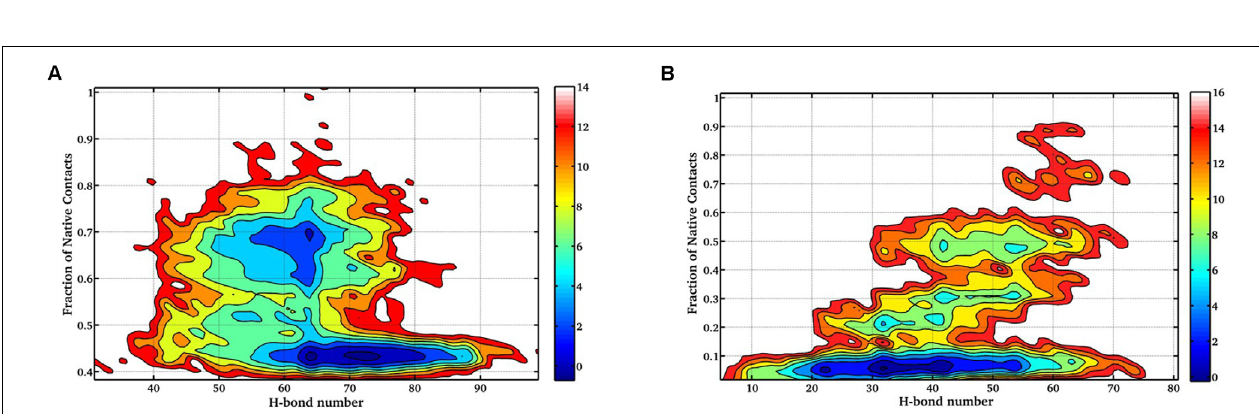
FIGURE 3 | The free energy landscape (FEL) of NTD during thermal unfolding. Free energy contour maps constructed at 400 K from (A) Nc vs. C α -RMSD, and (B) Nc vs. Rg . Similarly, FEL at 450 K from (C) Nc vs. C α -RMSD, and (D) Nc vs. Rg . The color is scaled according to kcal mol − 1 . The dark blue region represents the energy minima and energetically favored protein conformations, and the yellow region represents the unfavorable high-energy conformations. RMSD, root mean square deviation.